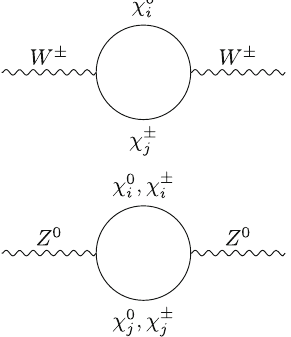
Fig. 6 One-loop Feynman diagrams for the vector boson self-energies with neutralinos and charginos in the loop